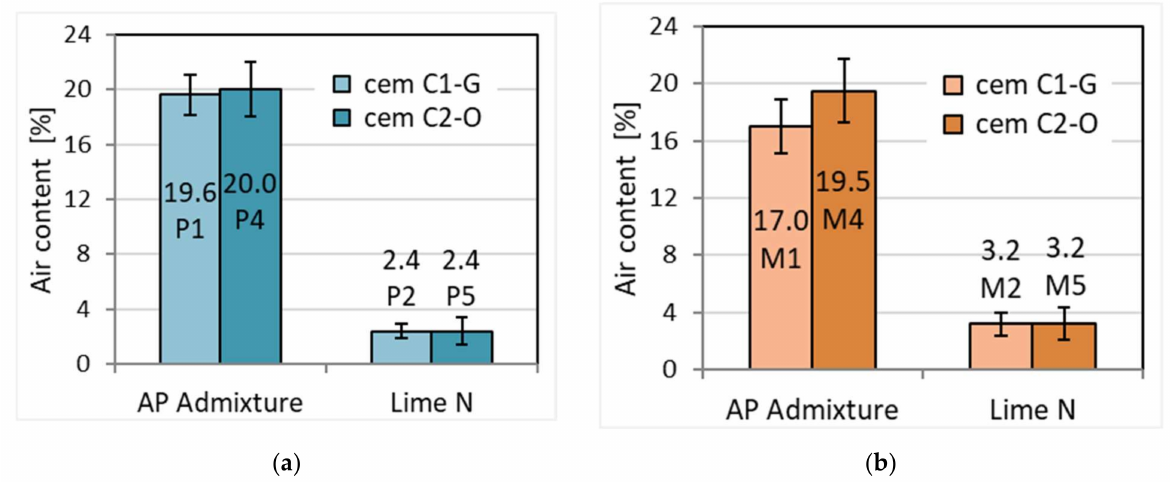
Figure 2. The effect of cement type and admixture type on the air content of ( a ) plaster and ( b ) masonry mortar.